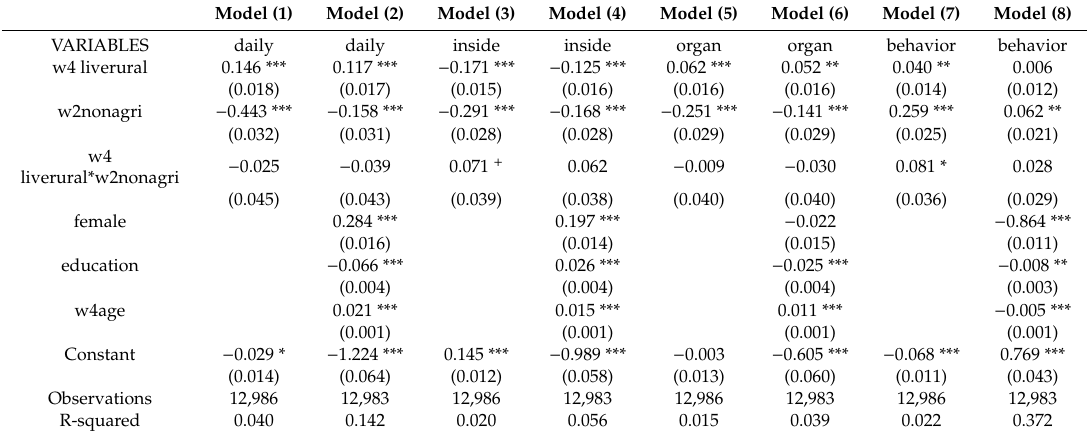
Table 15. Using di ff erent health factors as dependent variables to employ a robustness